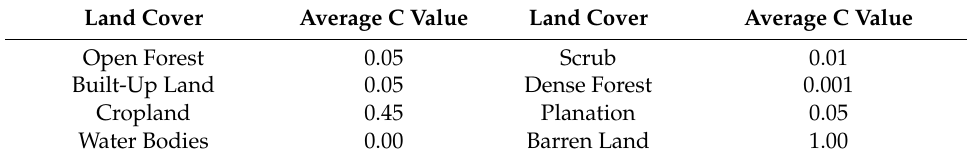
Table 1. C values for different land use patterns (after Morgan [19], Hashim and Wong 1988, [35]).